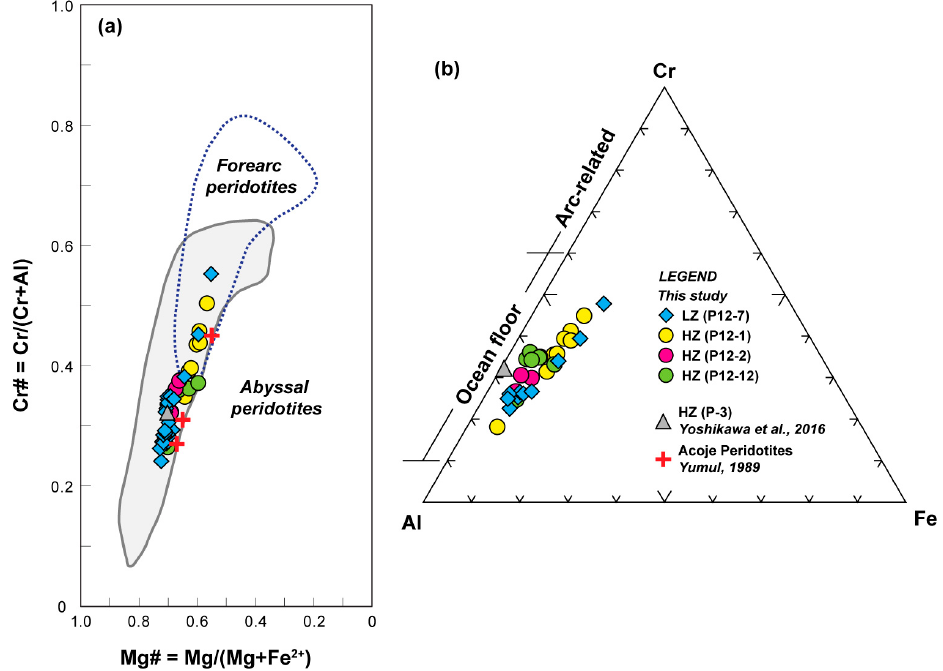
Figure 5. ( a ) Cr# vs Mg# of chromian spinels in the Mt. Pinatubo spinel peridotite xenoliths. Data for the least metasomatized coarse-grained, spinel harzburgite xenolith from Mt. Pinatubo reported by Yoshikawa et al. [25] is indicated by the gray triangle. Red crosses (+) are chromian spinel data of the Acoje peridotites of the Zambales Ophiolite Complex [46]. Abyssal peridotite [43] and forearc peridotite fields [9,44] are also shown. ( b ) Ternary diagram showing the Cr-Al-Fe 3+ content in the chromian spinels in the Mt. Pinatubo spinel peridotite xenoliths. Note that a few of the chromian spinels in the spinel lherzolite plot toward the Fe-rich end of the diagram. Abbreviations: LZ = spinel lherzolite and HZ = spinel harzburgite.